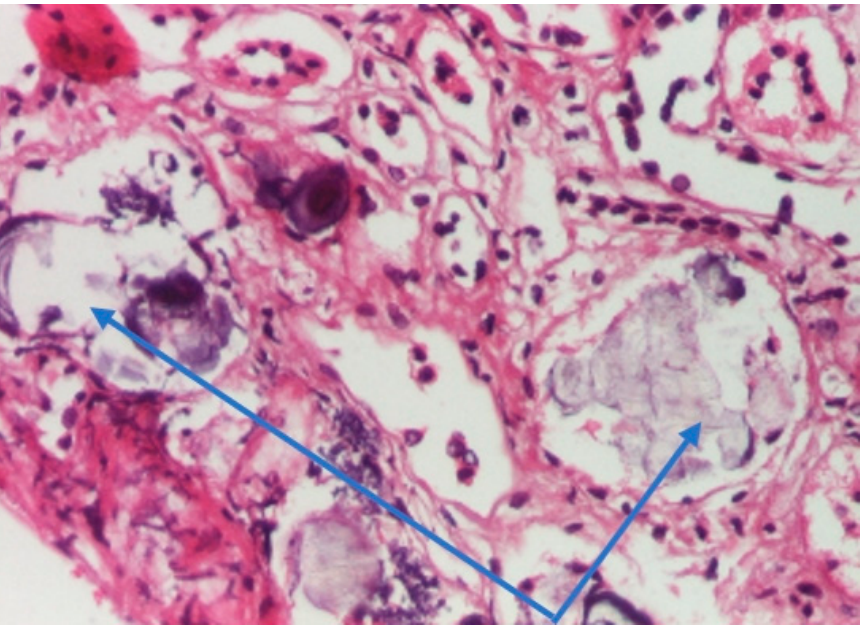
Figure 8. Hematoxylin-eosin staining × 200; renal tissue showing calcifications (blue arrows) (per- sonal collection, St. Mary Emergency Children’s Hospital, Iasi).